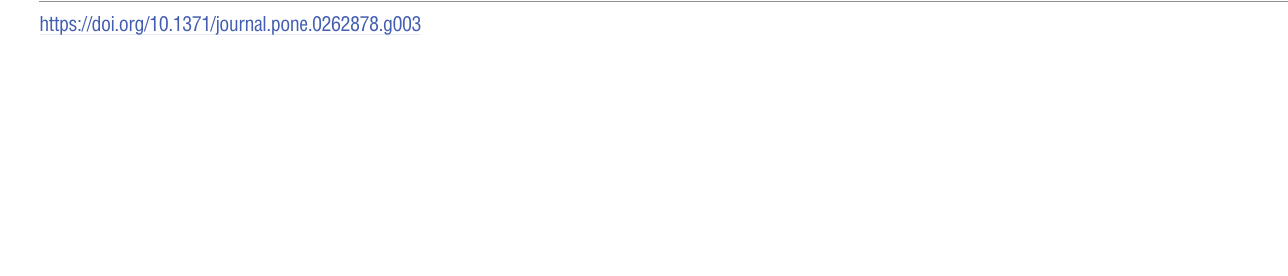
PLOS ONE | https://doi.org/10.1371/journal.pone.0262878 January 25,